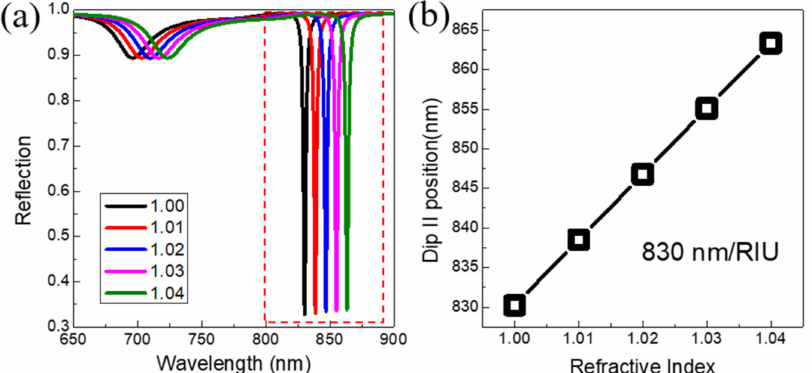
Figure 6. ( a ) The calculated normal-incidence reflection spectra of the Au VSRRs on Au substrate with TM polarization immersed in different environment media. ( b ) The resonance wavelength of the dip II extracted from ( a ) as a function of refractive